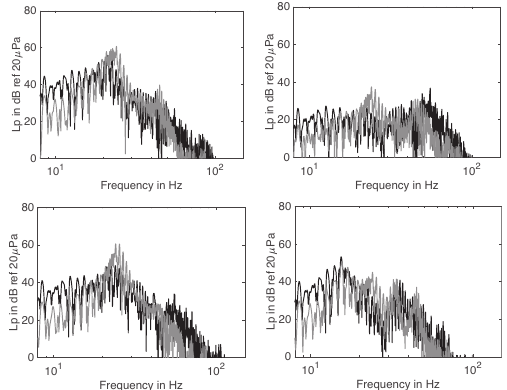
Figure 9. Comparison between the room model (black) and the recording in the living room lab (light gray) for the fl oors M1 (left upper corner), M4 (right upper corner), M9 (left lower corner) and M10 (right lower corner). Narrow band spectrum with D f = 0.03 Hz.